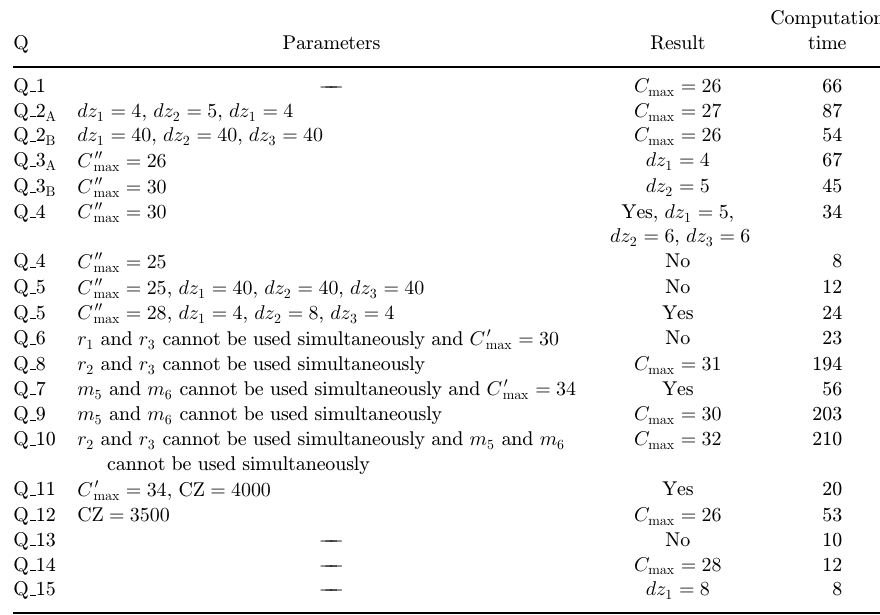
Table 3. Obtained results of the numerical experiments for the asked questions Q 1 – Q 12.